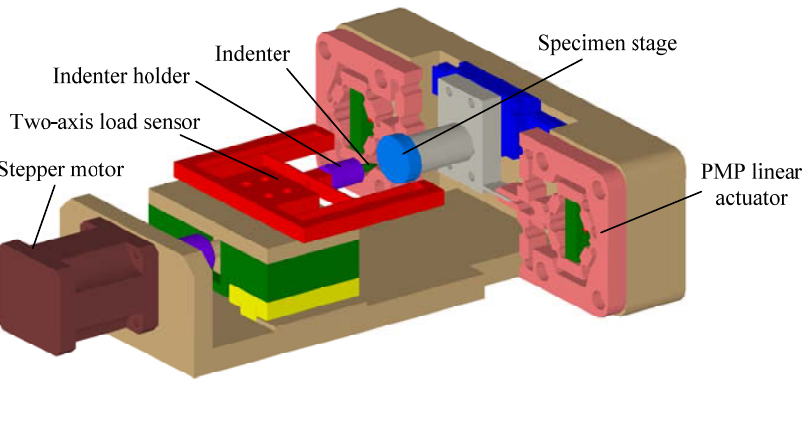
Figure 13. Preliminary model for the application of in situ scratch